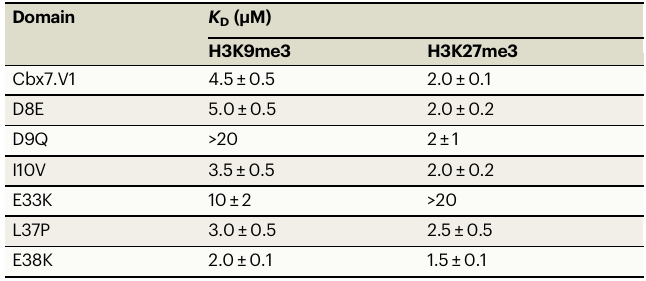
Table 1 | Dissociation constants for Cbx7.V1 and back-mutants for methyllysine-containing peptides Domain